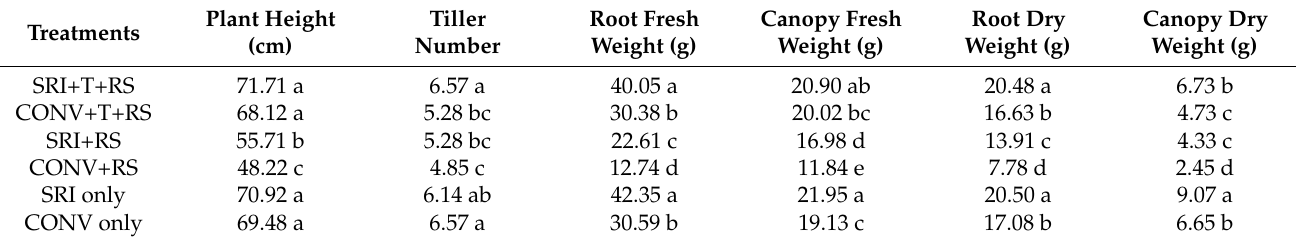
Table 3. Rice plant growth responses to R. solani